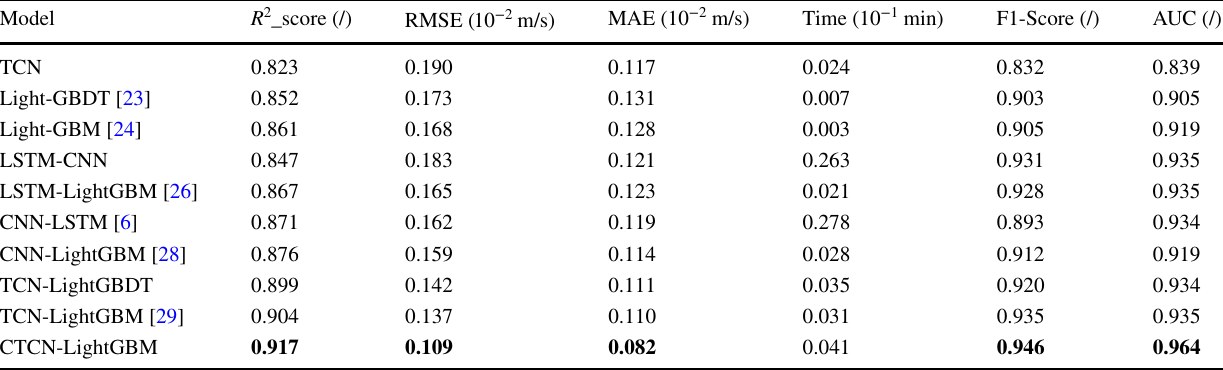
The bold values indicate superior metric values of the proposed Table 13 The prediction and classification results of all models for the truck speed adjustment